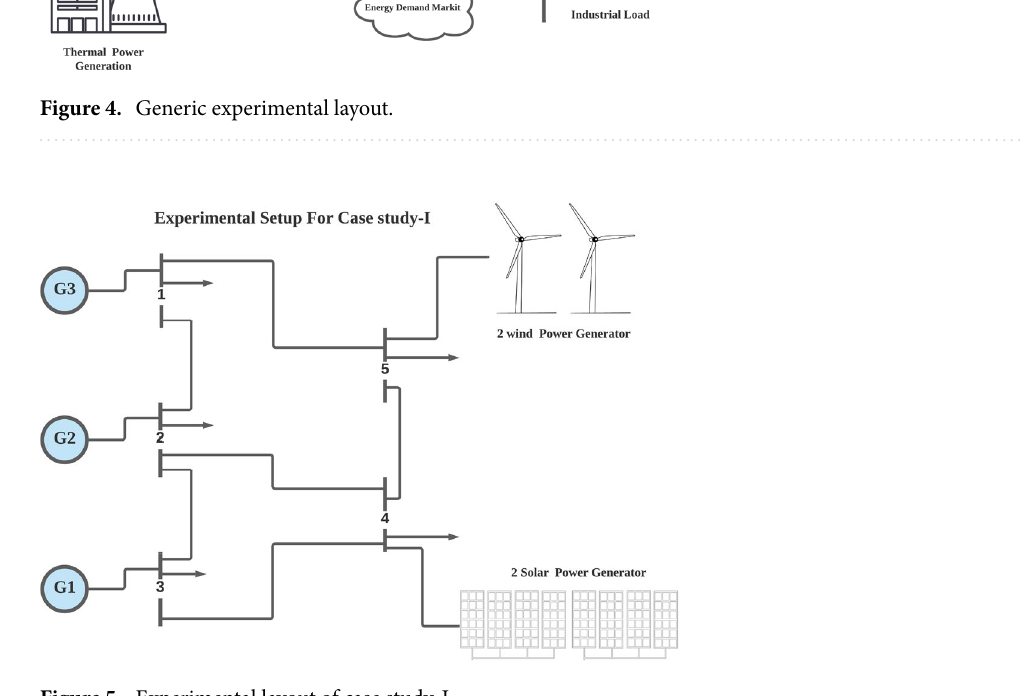
Figure 5. Experimental layout of case